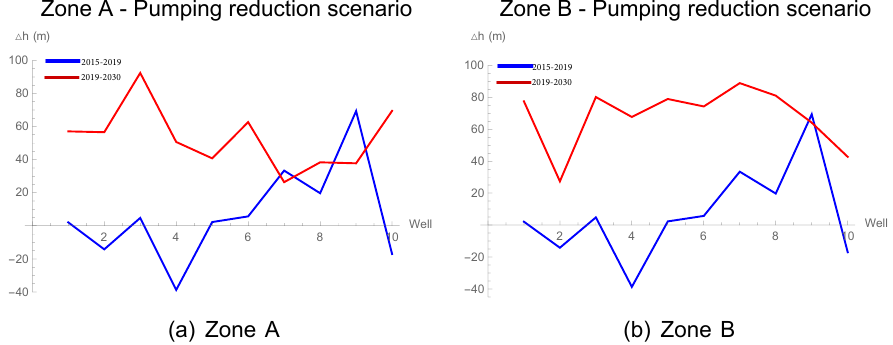
Figura 3.12: Isol´ıneas de la carga hidr´aulica del a˜no 2030 a trav´es del escenario Reducci´on de Bombeo en la Temporada de Secas.